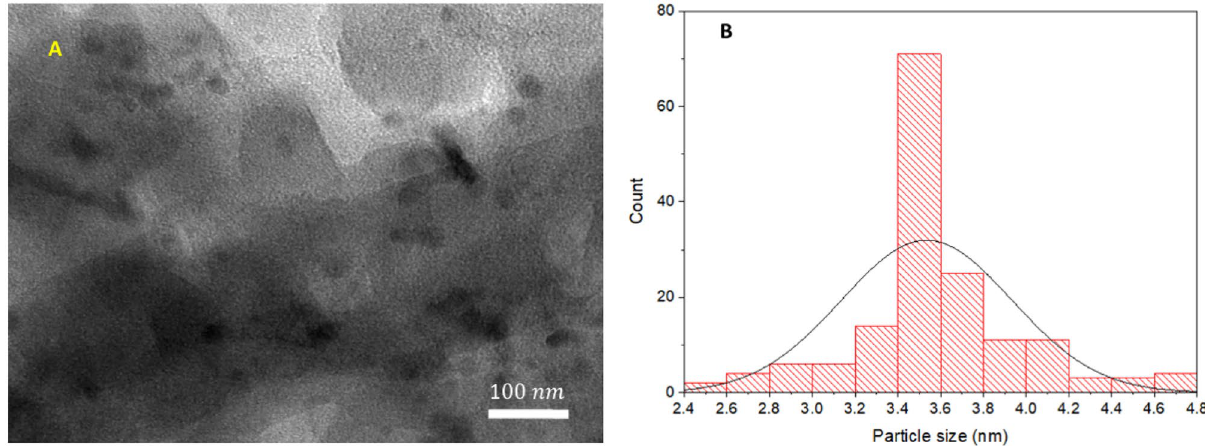
Figure 11. ( A ) TEM image and ( B ) particle size distribution curve for Pd NPs of the recycled catalyst after last run of the reaction.